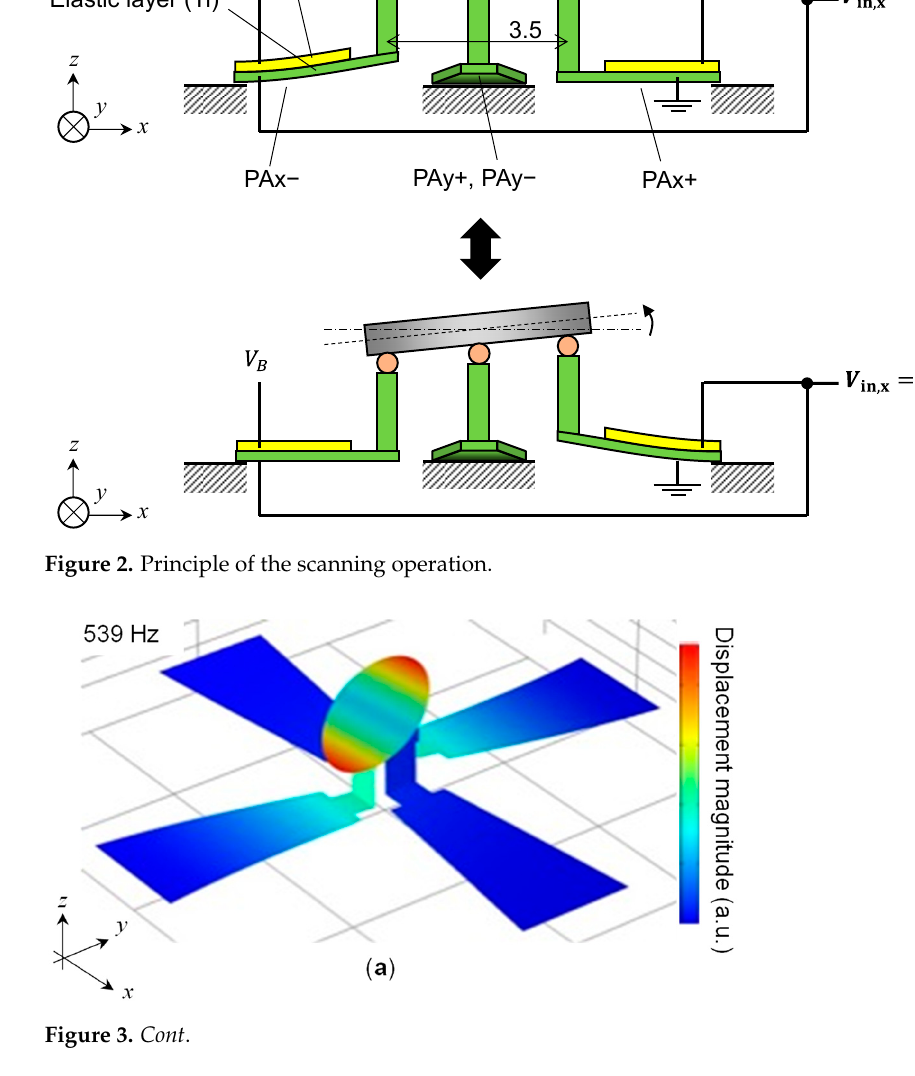
Figure 3. Result of the modal analysis: ( a ) First and ( b ) second resonant mode shapes. Figure 4. Result of the shock analysis: deformation shapes and strain contour plots when the maximum first principal strain was observed for an acceleration of 3000 G along the z -axis applied for 0.3 ms. 2.2. Fabrication The scanner consists of three main parts: a mirror, transmission, and piezoelectric actuator (upper part of Figure 5). The mirror was constructed by laser cutting a 300- μ m- thick silicon wafer. The transmission is a laminated structure of titanium and polyimide, as described above. It was fabricated by bonding pre-patterned titanium and polyimide layers via thermocompression bonding. A detailed fabrication process is reported in [35]. The piezoelectric actuators were fabricated by bonding PIN-PMN-PT and the titanium layers with an epoxy resin (Quick 5; Konishi Co., Ltd., Osaka, Japan), and PIN-PMN-PT with an Au electrode was manufactured by TRS Technologies, Inc. (State College, PA, USA). Four piezoelectric actuators, two transmission parts, and a mirror were assembled, as shown in the lower part of Figure 5. Here, the hinge components, fabricated in a planar